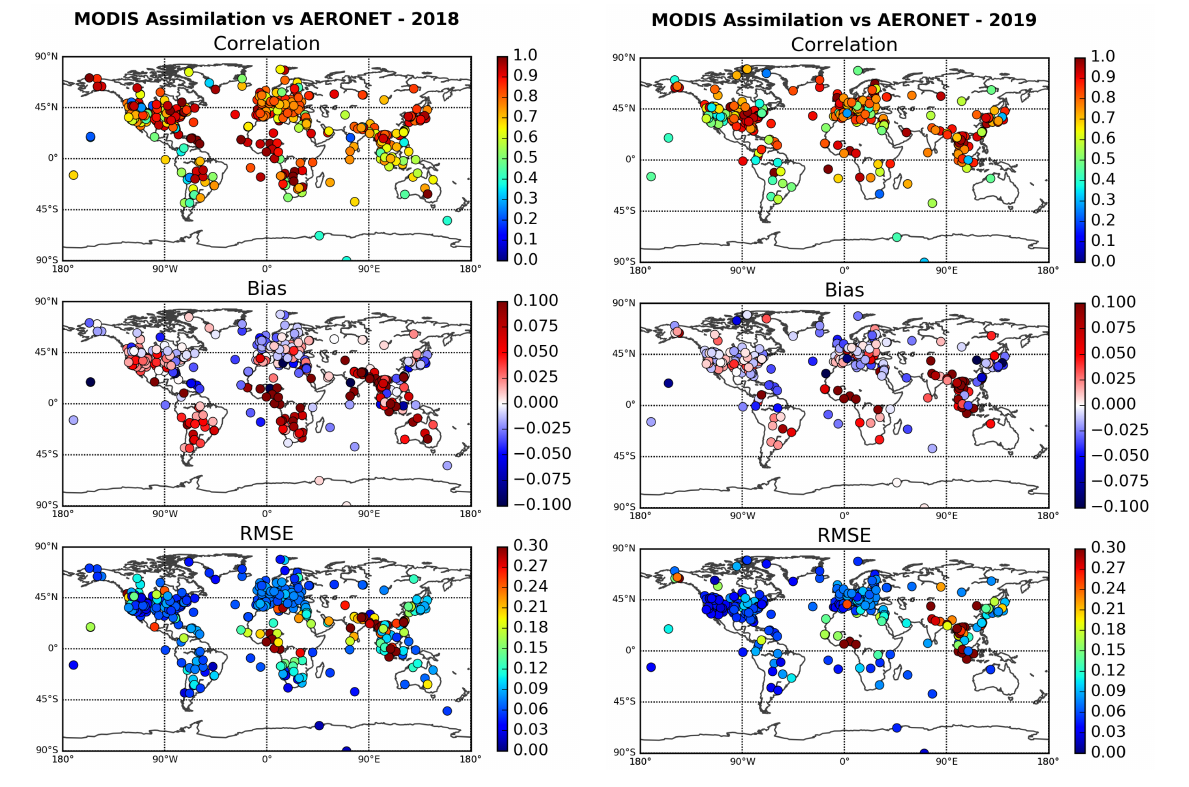
Figure 2. Statistics in terms of correlation, bias and RMSE between AERONET observations and MODIS analyses in terms of AOD for both the years of assimilation: 2018 and 2019. Note that all AERONET observations (Version 3) available during the whole two-years period (2018 and 2019) over all the globe are considered in this